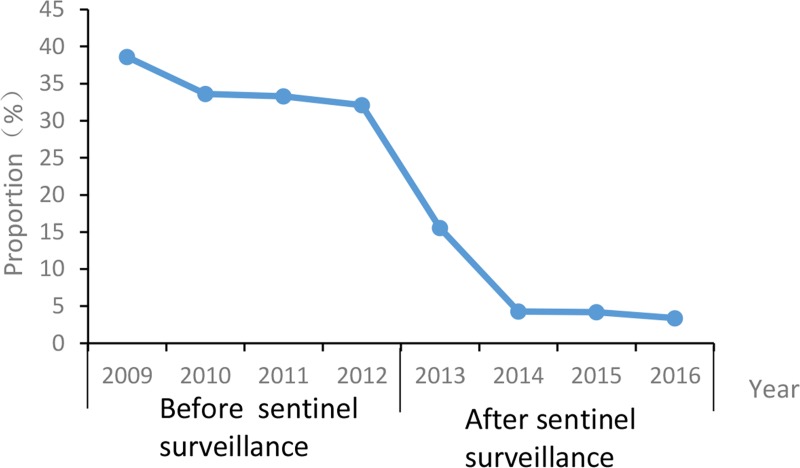
The proportion of unclassified hepatitis B, China, before and after sentinel surveillance.Fig 4 represents the proportion of unclassified hepatitis B, China, before and after sentinel surveillance. The proportion of unclassified hepatitis B is equal to the number of unclassified hepatitis B divided by the total number of hepatitis B cases.